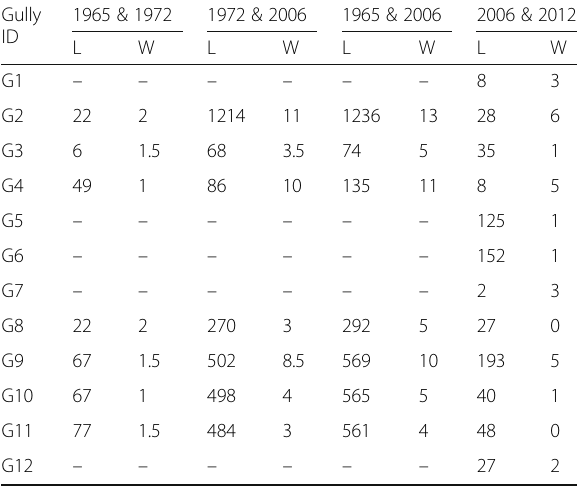
Table 5 Change of gully length and width from 1965 to 2012 Gully